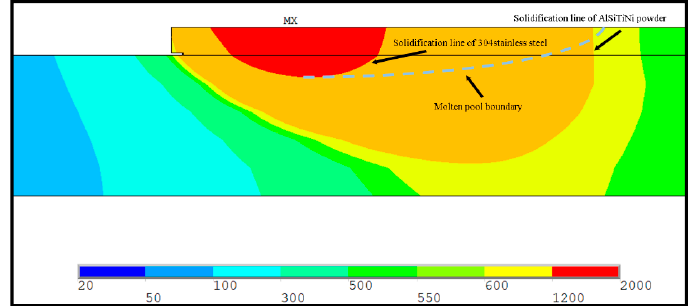
Figure 15. A schematic illustration of the molten pool boundary.